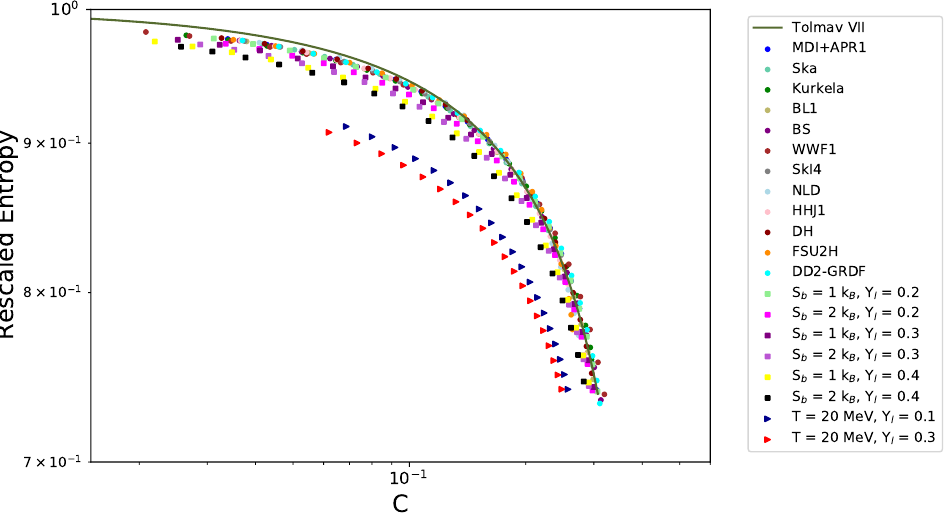
Figure 3. The rescaled entropy as a function of the star’s compactness for cold and hot (isothermal and isentropic) EOSs. The circular points correspond to cold EOS, whereas the rectangular and the triangular points stand for isentropic and isothermal neutron stars, respectively. The solid line is the prediction of the Tolman VII